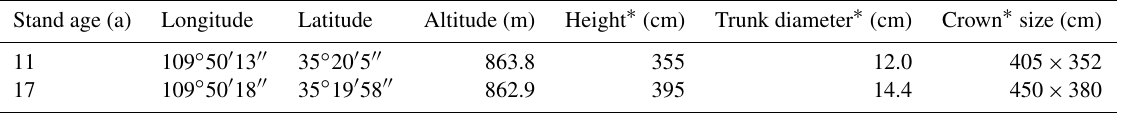
Table 1. General information on the two apple orchards. Stand age (a) Longitude